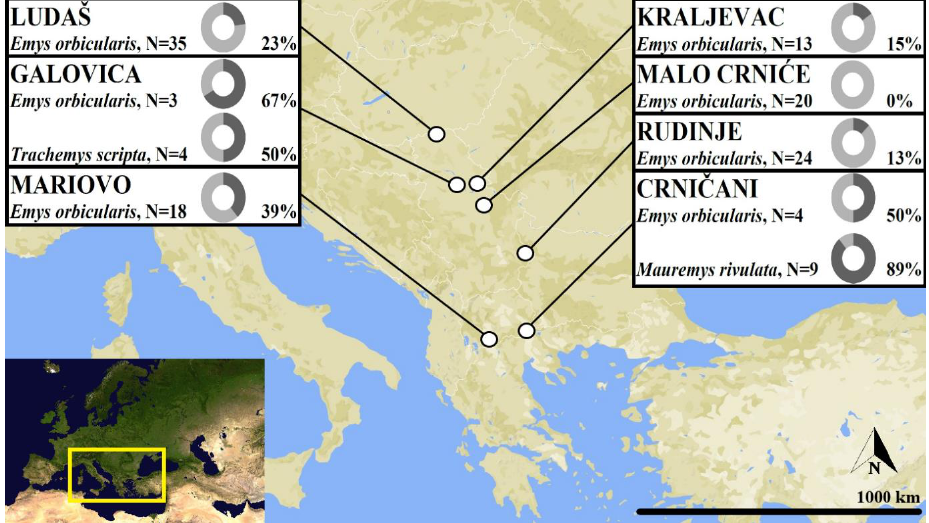
Figure 1. Map showing the sampling localities of pond turtles. Insets show the number of each host species assessed, and the percent infected with haemogregarines, as determined by PCR and DNA sequencing.